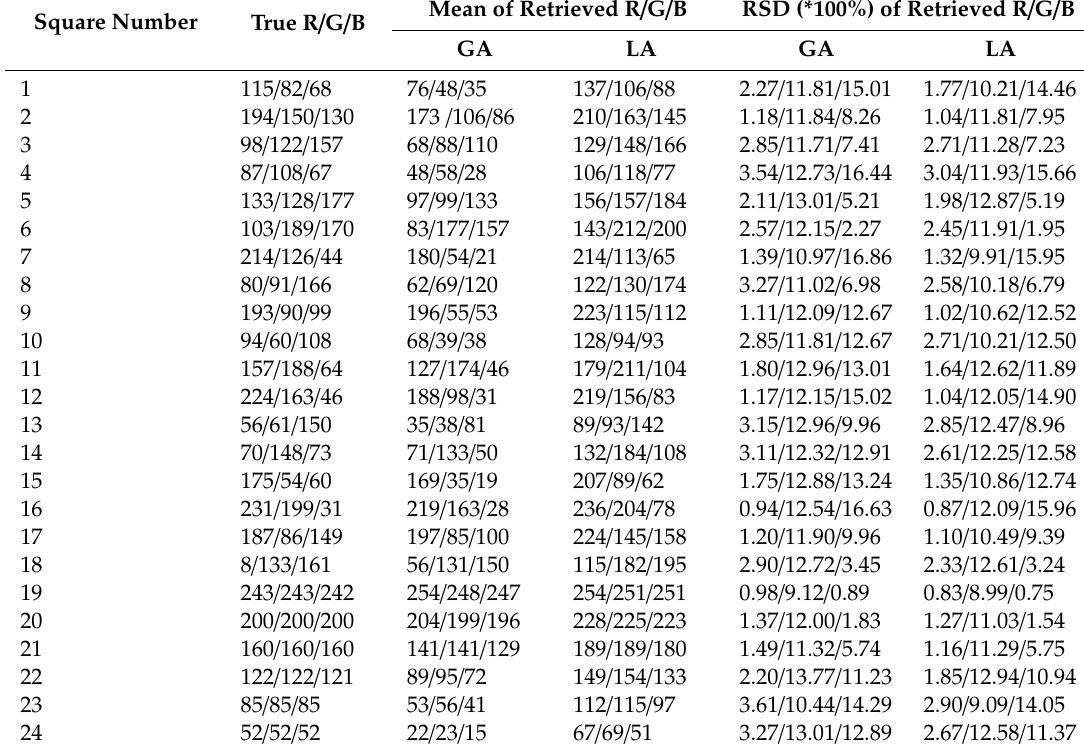
Table 2. Quantitative analysis of the retrieved RGB values for the point